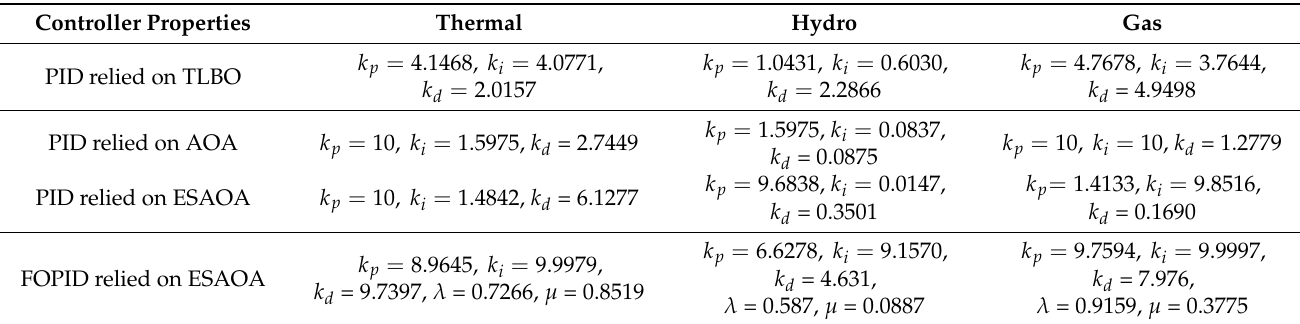
Table 6. The optimal controllers’ values for scenario